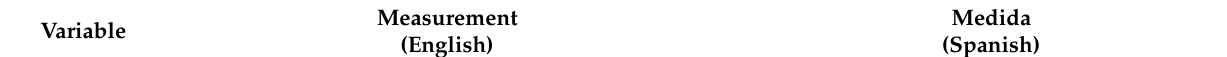
Table A1. Variables considered in this research, with respective questions included in the survey, as displayed for the respondents (in English, as well as in the original language,